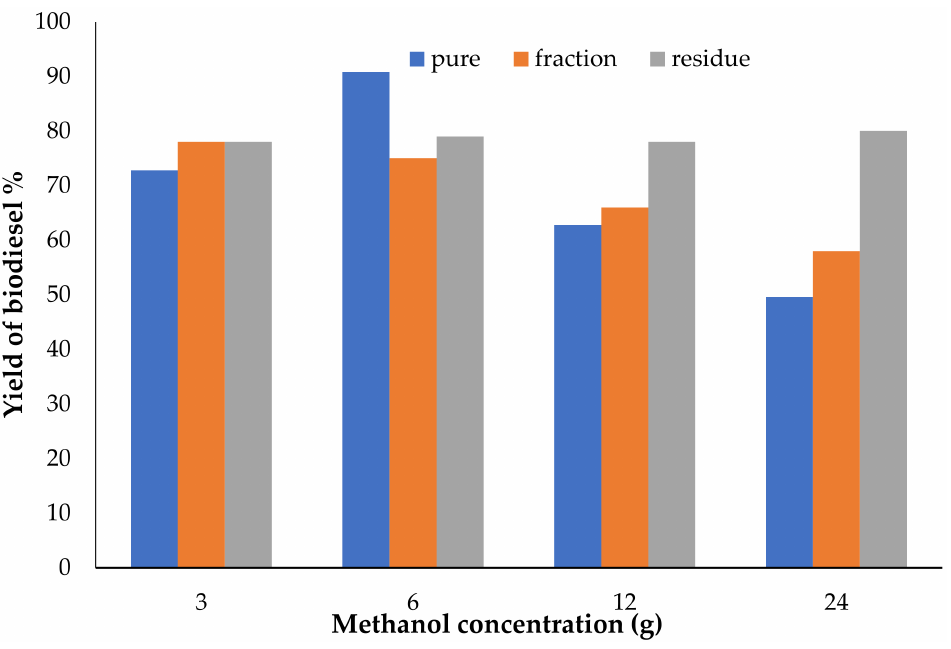
Figure 9. Effect of methanol concentration on the yield of biodiesel produced from the hydrolyzed pure oil, fraction of oil, and residue.